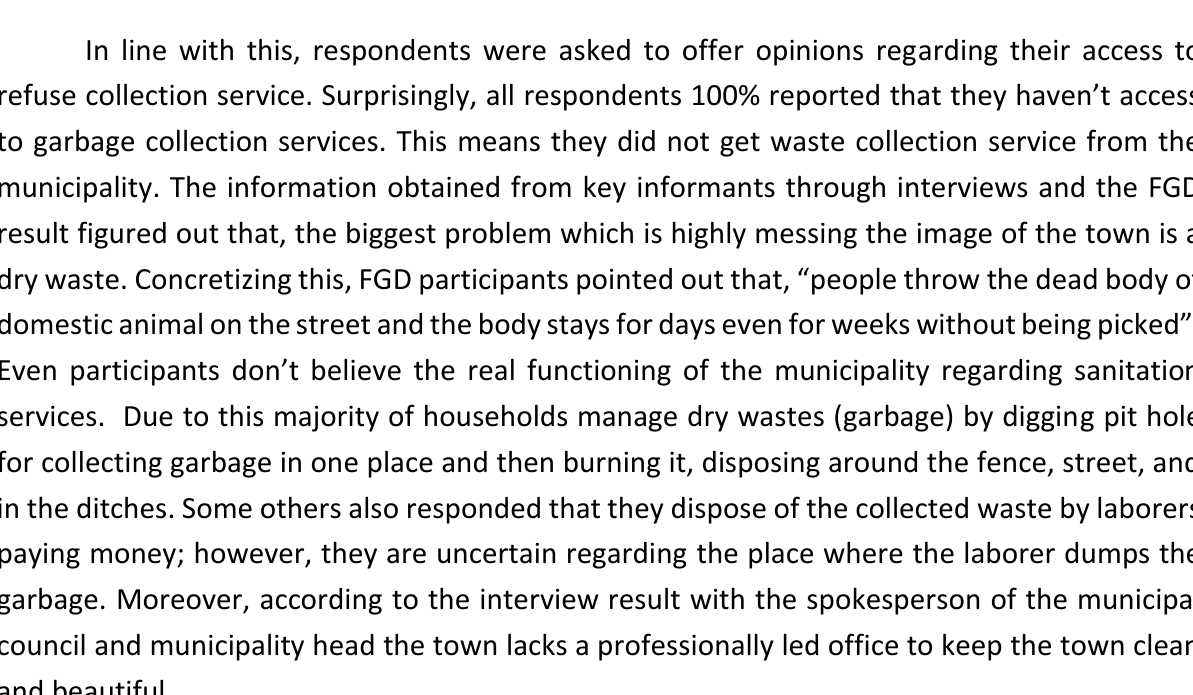
Table 21: public satisfaction on municipal service provision Kebele How satisfied are you with the overall service Total provision of the municipality regarding pure water supply and refuse collection? Dissatisfied Very